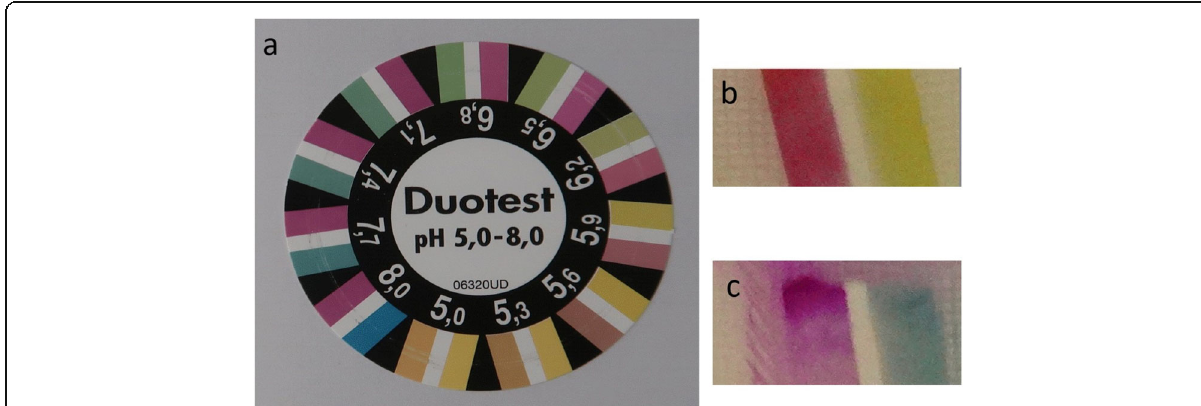
Fig. 1 pH test paper. a Duotest pH 5.0 – 8.0®, MACHEREY-NAGEL GmbH & Co. KG. These indicator papers show two different colors for each pH value at intervals of 0.3 – 1 pH units. This allows for more accurate reading and a good estimation of intermediate values. The two sidebands are indicators and change color. The white center band separates the above two bands to avoid fusion of the indicator dyes. The pH value of the target sample is decided by comparing its color with this color chart. b Mepivacaine on a pH test paper. It is a representative sample of mepivacaine determined to have a pH of 6.2. c Cerebrospinal fluid on a pH test paper. The upper part of the figure corresponds to the center of a . It is a representative sample of CSF determined to have a pH of